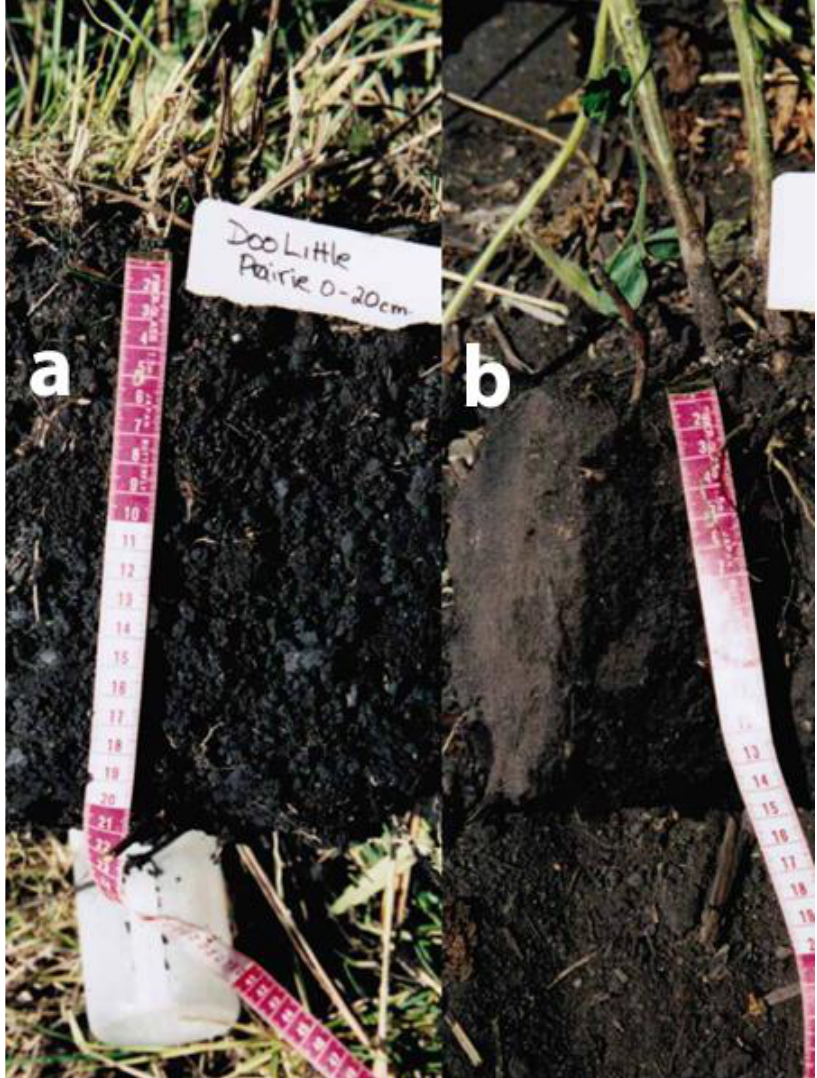
Figure 1. Comparison of soil developed under continuous prairie vegetation (a) and an adjacent soil (b) under decades of continuous cultivation. The profiles visually illustrate the loss in soil structure incurred from repeated tillage and the consequent loss in soil organic carbon. The undisturbed soil is richly aggregated in the upper 0–20 cm A-horizon, whereas the cultivated soil has a shallower depth of the A-horizon that is lighter in color, and has less aggregation. Photo: David Laird.